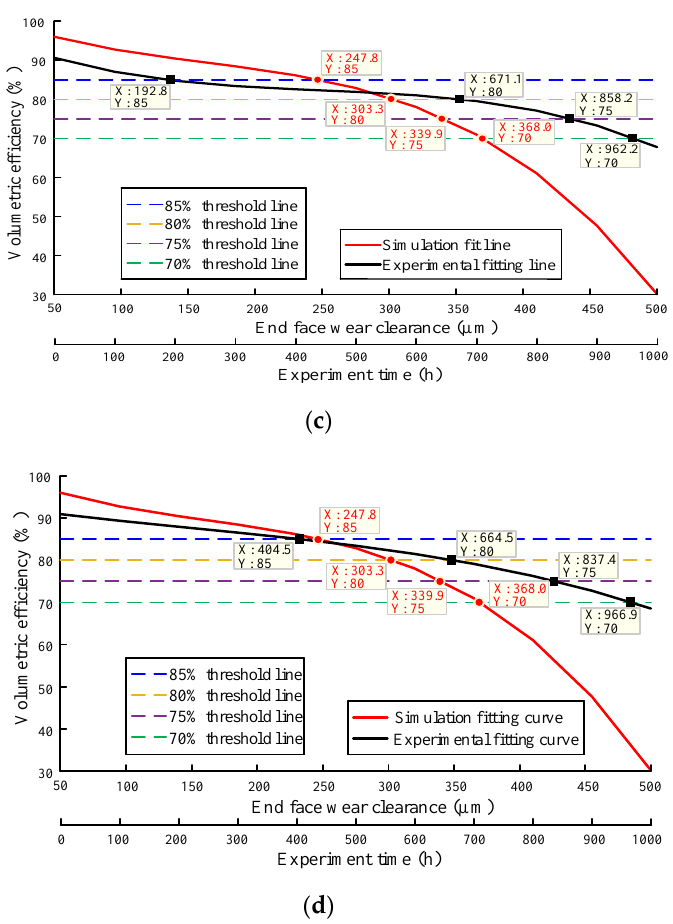
Figure 23. The fitting curve of the test data and the simulated fitting curve under the end face wear